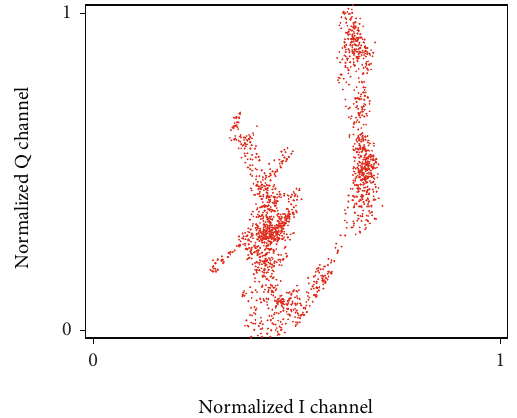
Figure 11: The constellation of I / Q signal when the subject under normal